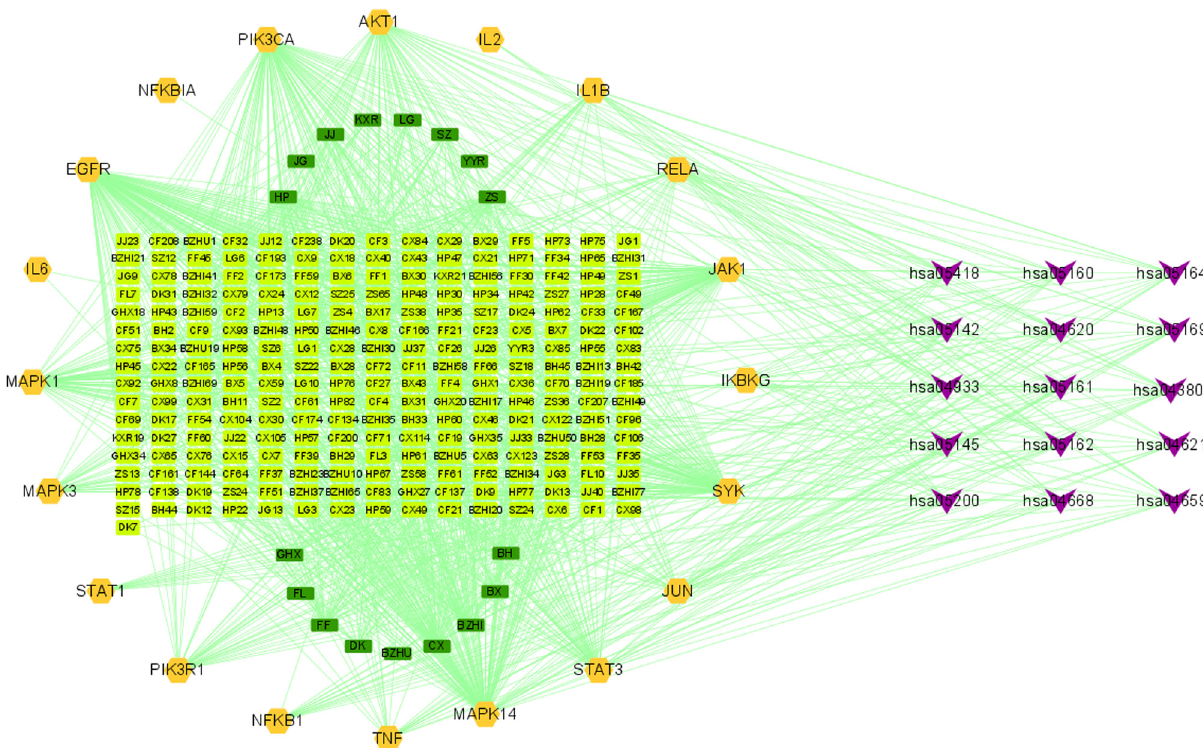
Figure 4: Drug – Core active component – Key target – pathway network. The dark green squares are the medicinal herbs, the light green squares are the core active ingredients, the yellow octagons are the key targets, and the purple V shapes are the